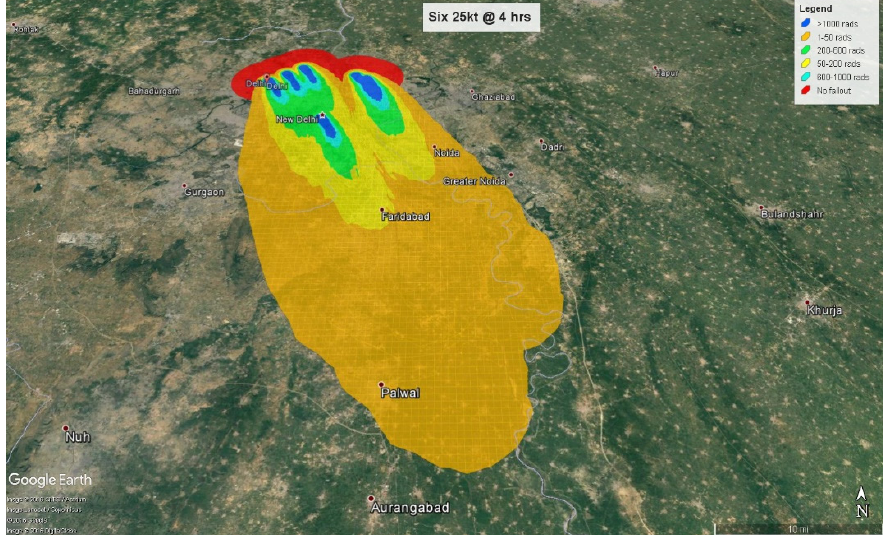
Figure 7. Fallout exposure (24 h) by triage categories.